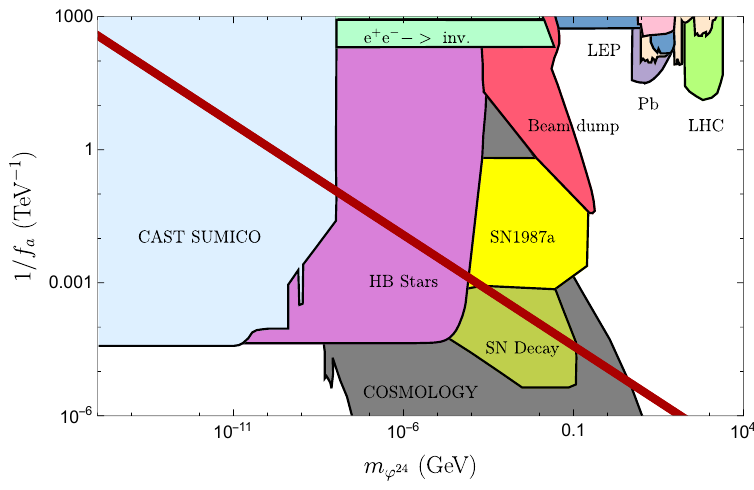
Figure 2 . Figure showing bounds on the ALP parameter space with the prediction of the composite ALP shown as the dark red band. Note that the bound from cosmology (gray color) depends on the emergent ALP being the dominant DM component. If its abundance is negligible, then SN constraints are the strongest, implying m > 0 . 1 GeV in that ϕ 24